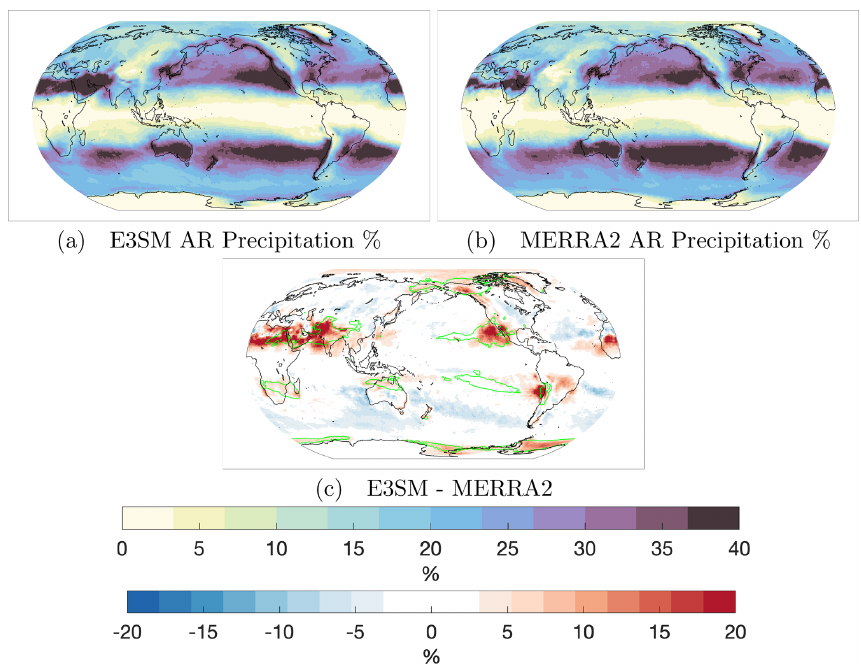
Figure 6. The fraction of annual precipitation attributed to ARs for each grid cell for (a) E3SM and (b) MERRA2. The difference (E3SM minus MERRA2) is shown in (c) . The color bar at the top (bottom) corresponds to the absolute (difference) percentages. Contour lines in (c) indicate the 1.5% positive AR frequency biases from Fig.